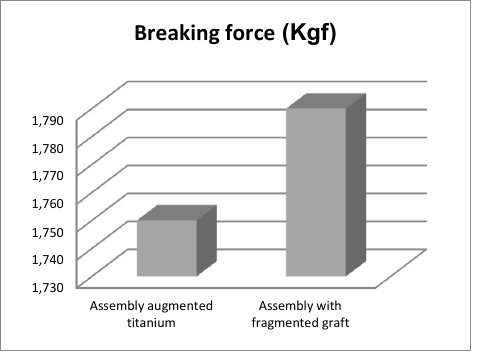
Figure 48. Stress maps for the system with morcellated bone graft.